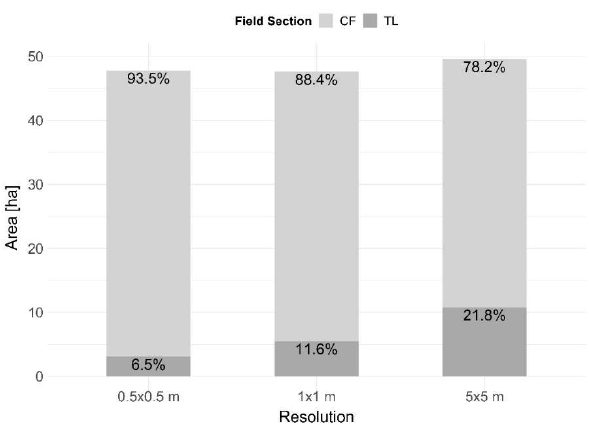
Figure 7. Comparison of varying tramline areas (TL) against cultivated field sections (CF) within the modelling approach for different raster resolutions.